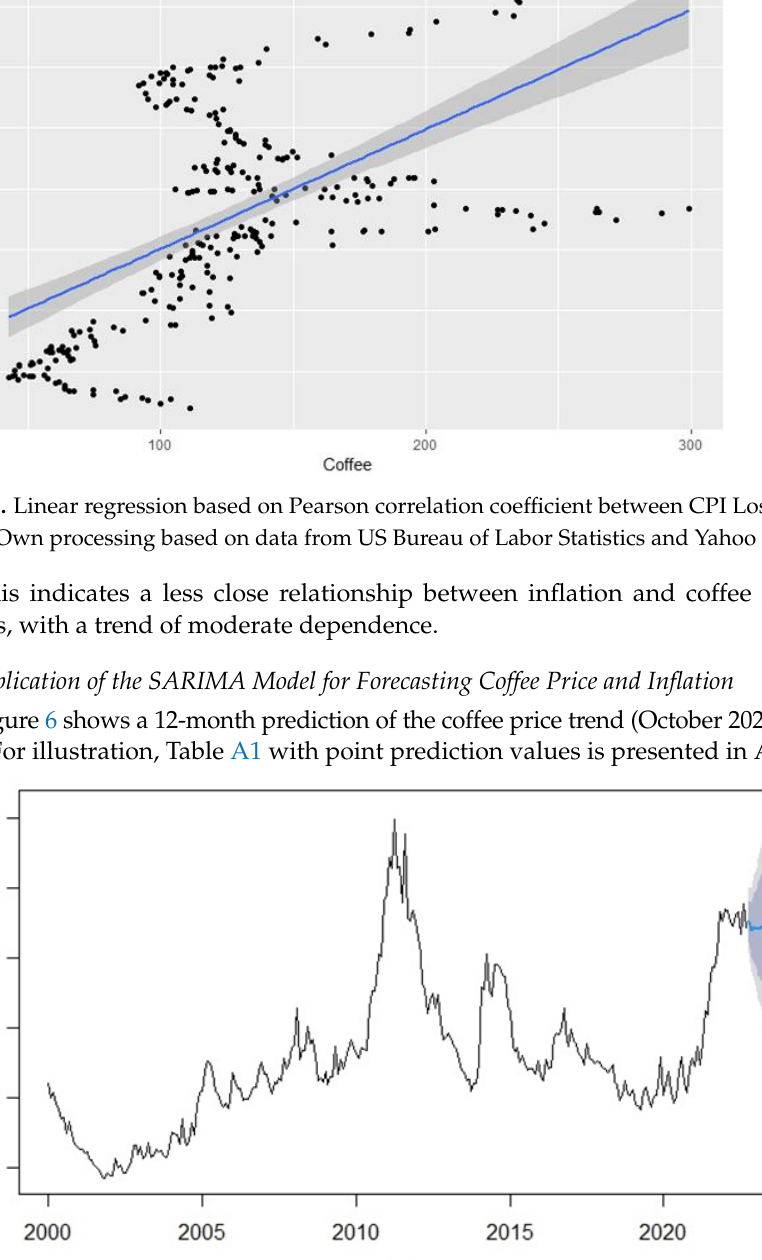
Figure 5. Linear regression based on Pearson correlation coefficient between CPI Los Angeles and